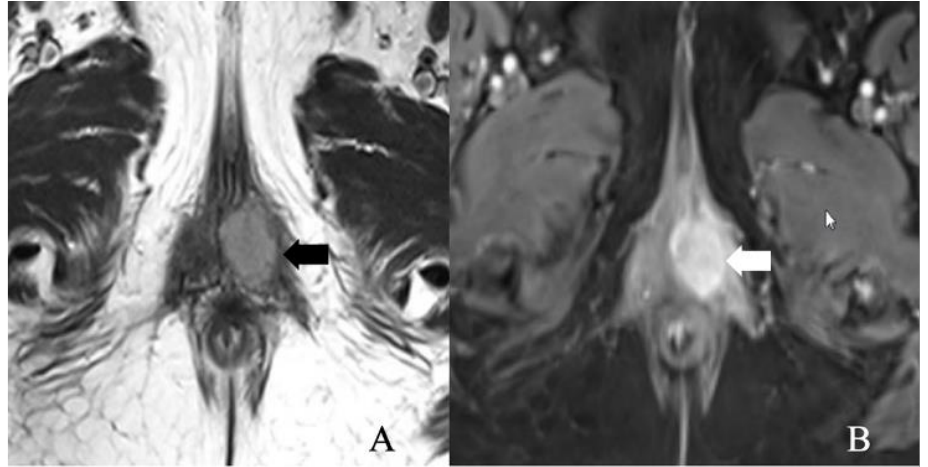
Figure 3. FIGO stage IA. A 43-year-old female with squamous cell carcinoma of the vulva. ( A ) Axial T2 weighted image and ( B ) post-contrast fat-saturated axial T1 weighted MRI image showing an